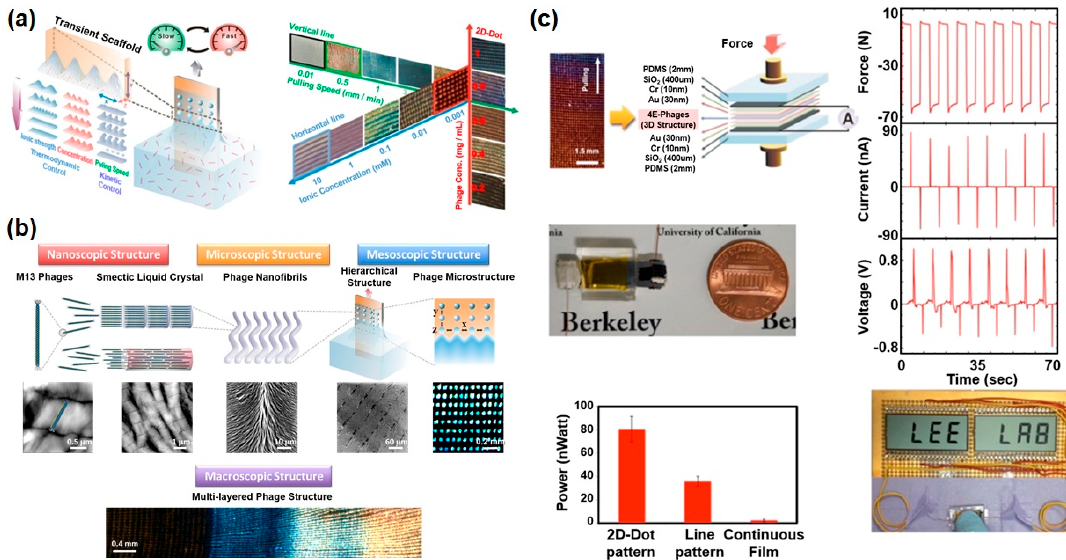
Figure 6. Characterization of an M13 bacteriophage-based piezoelectric energy generator. (biomimetic hierarchical structures). ( a ) Schematic illustration of the biomimetic hierarchical assembly process and structural transition diagram of phage films depending on phage concentration, ionic concentration, and pulling speed. Reproduced with permission from [30]. Copyright Elsevier, 2019. ( b ) Hierarchical structures of the phage-based films from nanoscale to macroscale. (single phage–phage filaments–fiber bundles–mesoscale periodic structure–macroscale band). ( c ) Piezoelectric characterization depending on phage structures. The 2D-dot patterns showed the highest piezoelectric performance, exhibiting peak values of 94 nA current and 0.95 V voltage. Reproduced with permission from [30].